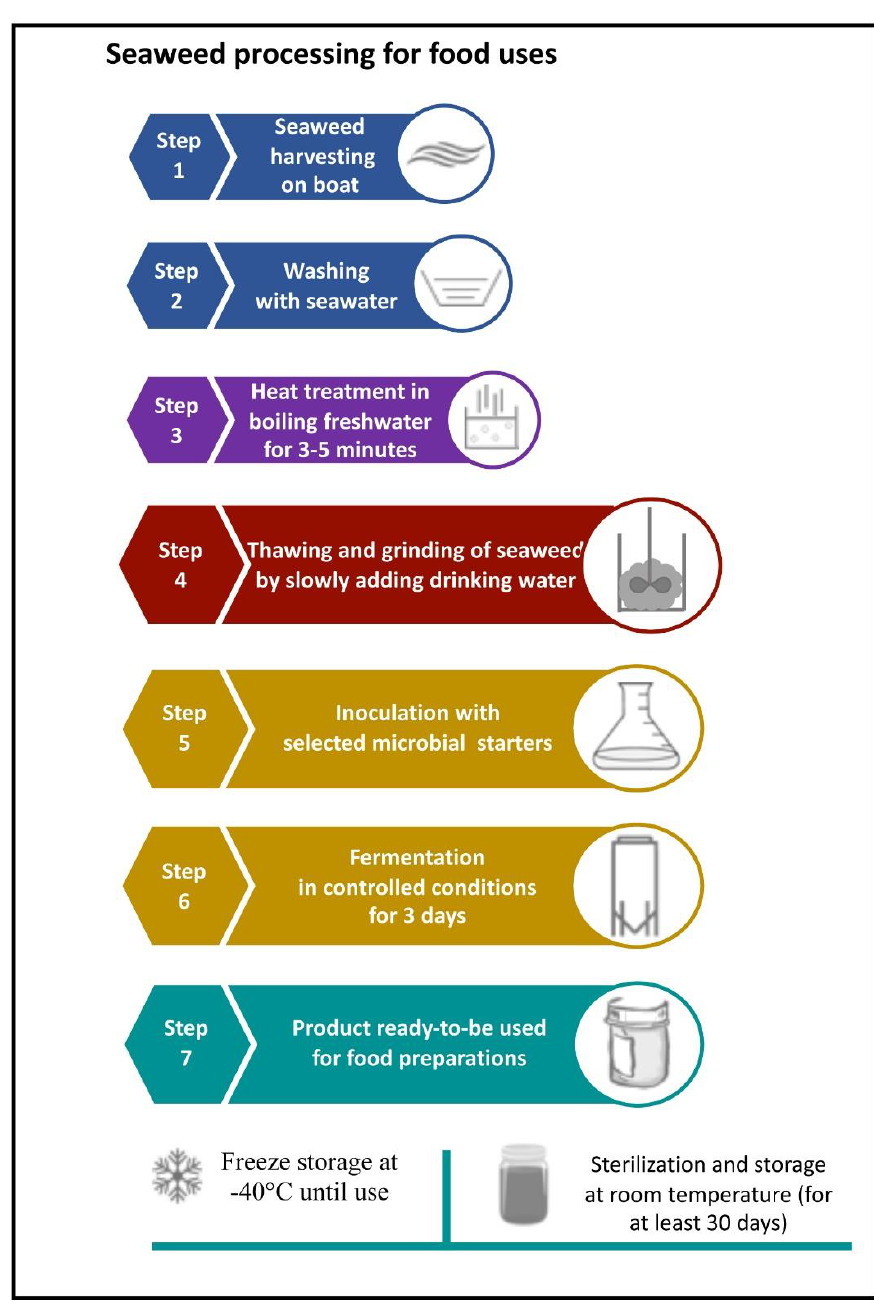
Figure 8. Diagram illustrating the optimized procedure for seaweed processing to obtain new food products.